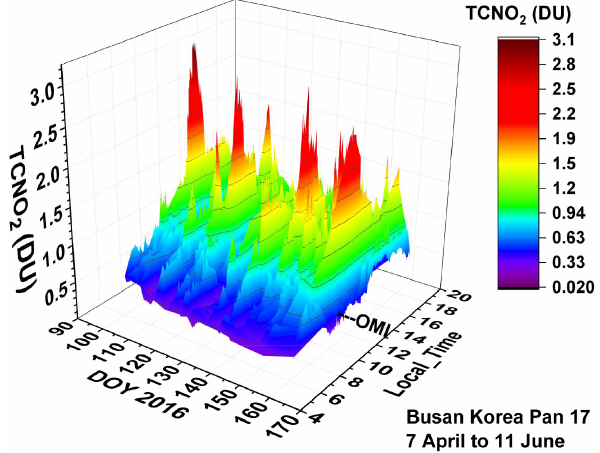
Figure 1. Diurnal variation of TCNO 2 measured at Pusan Univer- sity in Busan, South